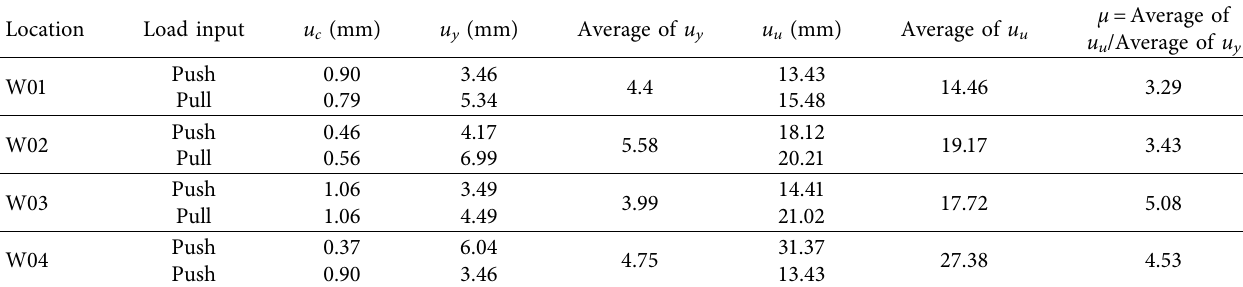
curve. In Table 3, K yield stiffness; K timate stiffness.